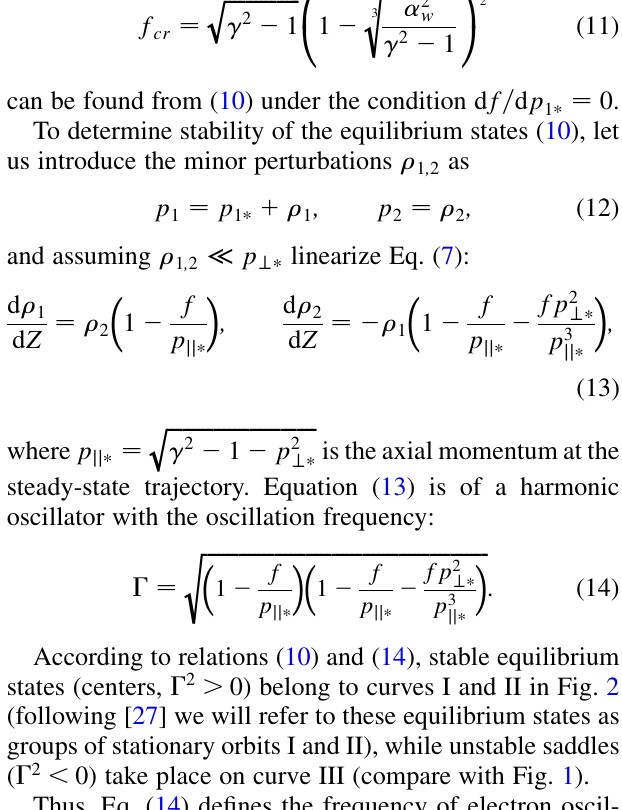
ffiffiffiffiffiffiffiffiffiffiffiffiffiffiffi